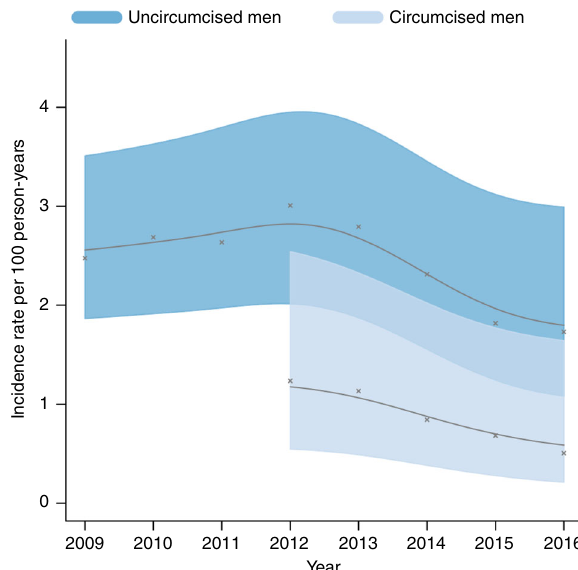
Fig. 4 Age-adjusted HIV incidence rates for men who reported being uncircumcised ( N = 5134) and circumcised ( N = 2306). Due to a small number of recorded seroconversions between 2009 and 2011, the incidence rate for circumcised men is plotted from 2012 to 2016. The fi gure shows that uncircumcised men had a lower incidence of HIV infection, and that declines in HIV incidence occurred after 2012 for both uncircumcised and circumcised